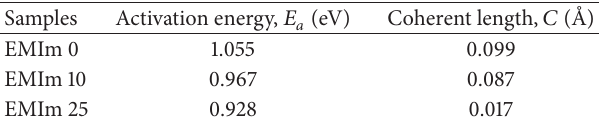
Figure 2: Arrhenius plots of ionic conductivity of EMIm 0, EMIm 10, and EMIm 25. Table 2: Activation energy and coherent length of EMIm 0, EMIm 10, and EMIm 25 obtained from temperature dependent ionic conductivity and XRD analysis.